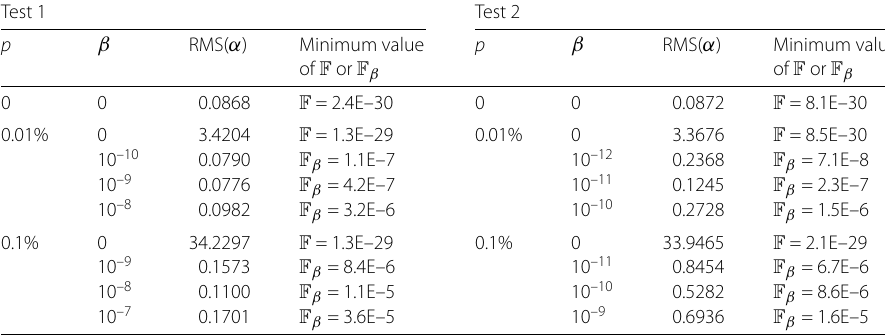
Table 2 The RMS values (32) for p ∈ { 0,0.01%,0.1% } and β ∈ { 0,10 –12 ,10 –11 ,10 –10 ,10 –9 ,10 –8 ,10 –7 } for Tests 1 and